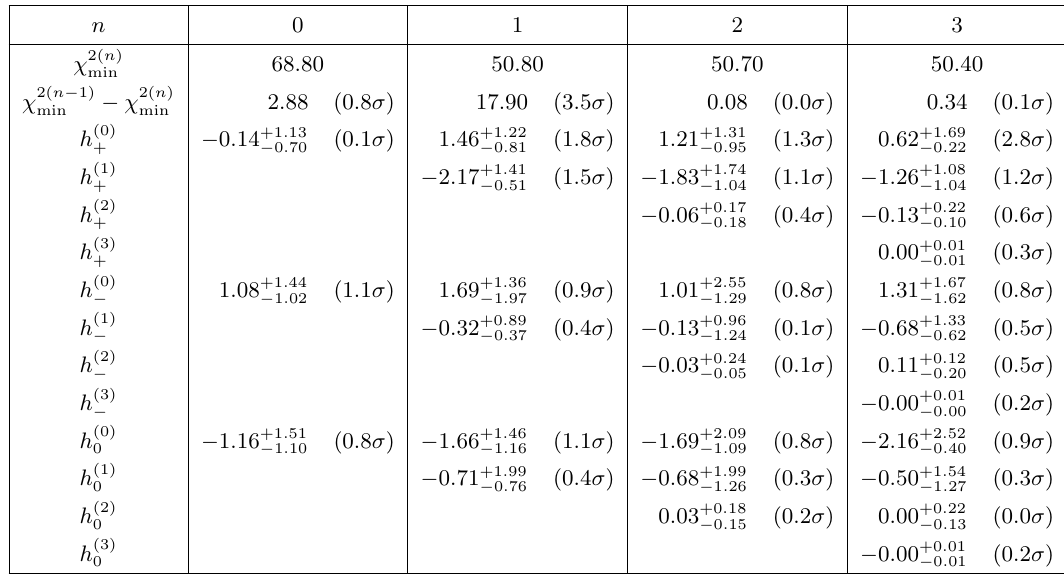
Table 3 . Fit to B ! K (cid:3) (cid:22) + (cid:22) (cid:0) only, with C (cid:22); NP = 0, using LCSR from ref. [17] in the soft-form- 9 factor approach employed by ref. [12]. All coe(cid:14)cients are given in units of 10 (cid:0) 4 . Di(cid:11)erent orders n of the polynomial parametrisation of the long-distance charm-loop contribution are considered.